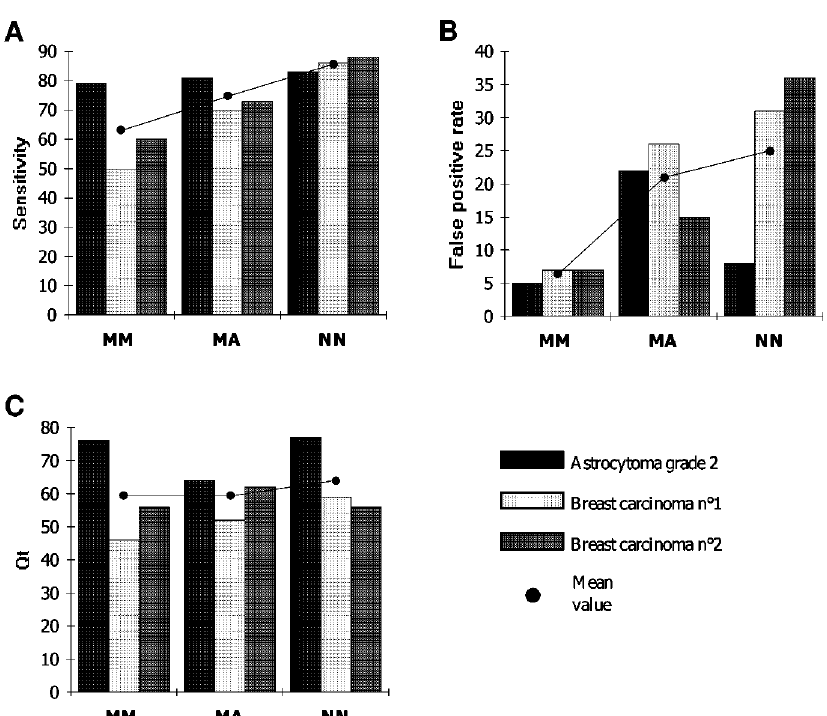
Fig. 1. Sensitivities (A), false positive rates (B) and quality factor of sorting (C) for the three cases and for the three automatic methods. Mean values for the three cases are represented as black dots for each